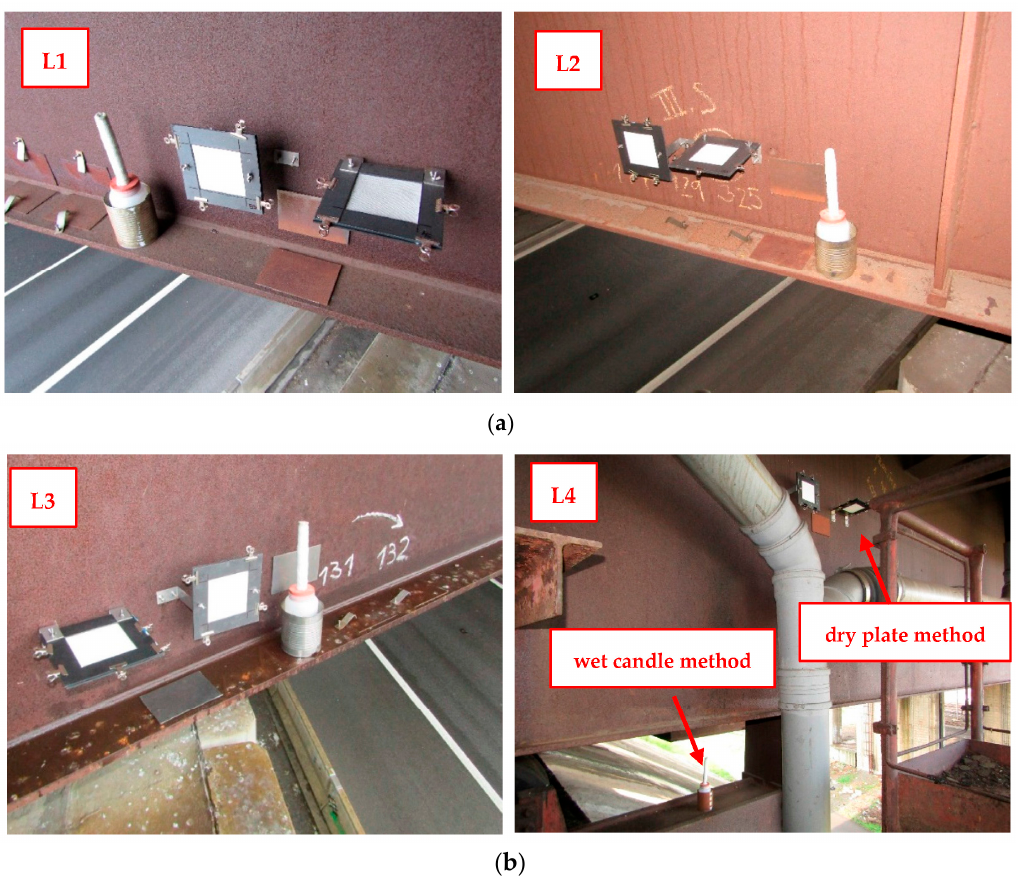
Figure 7. ( a ) Individual positions of the measuring devices on the selected bridges; ( b ) Individual positions of the measuring devices on the selected bridges.